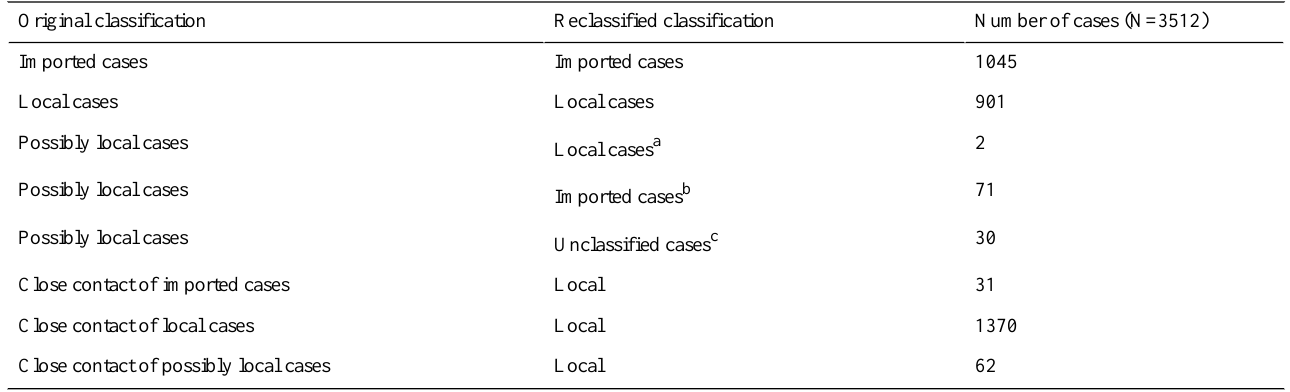
Table 1. Reclassification regime of